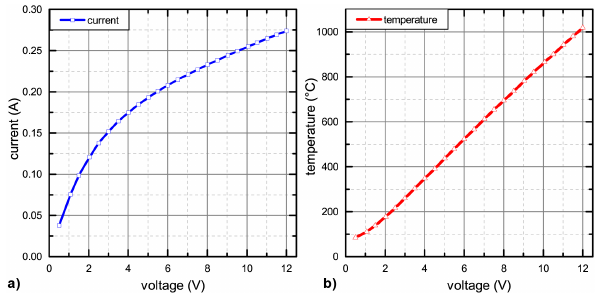
Figure 3. (a) Current–voltage characteristics of the ceramic heater used. (b) Derived temperature–voltage